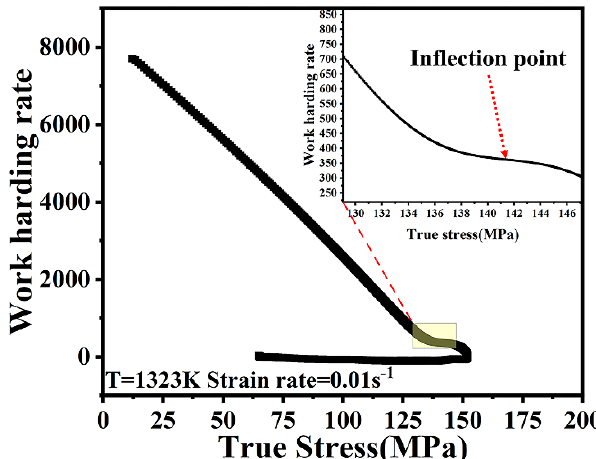
Figure 9. The relationship between work-hardening rate and the true stress.